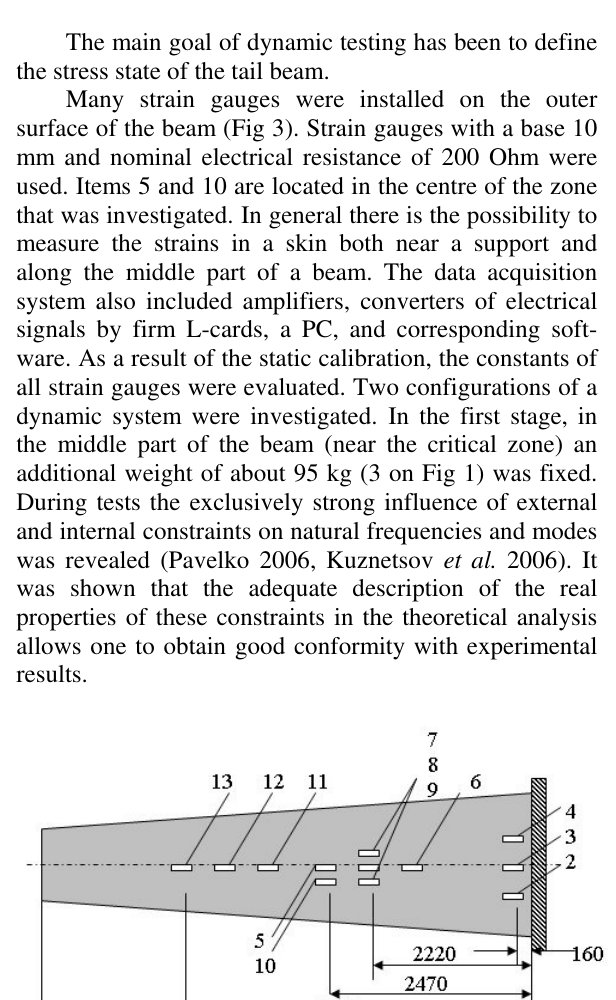
Fig 2. Picture of technological rivet-joint of stringers between frames 7 and 10 (outer view)